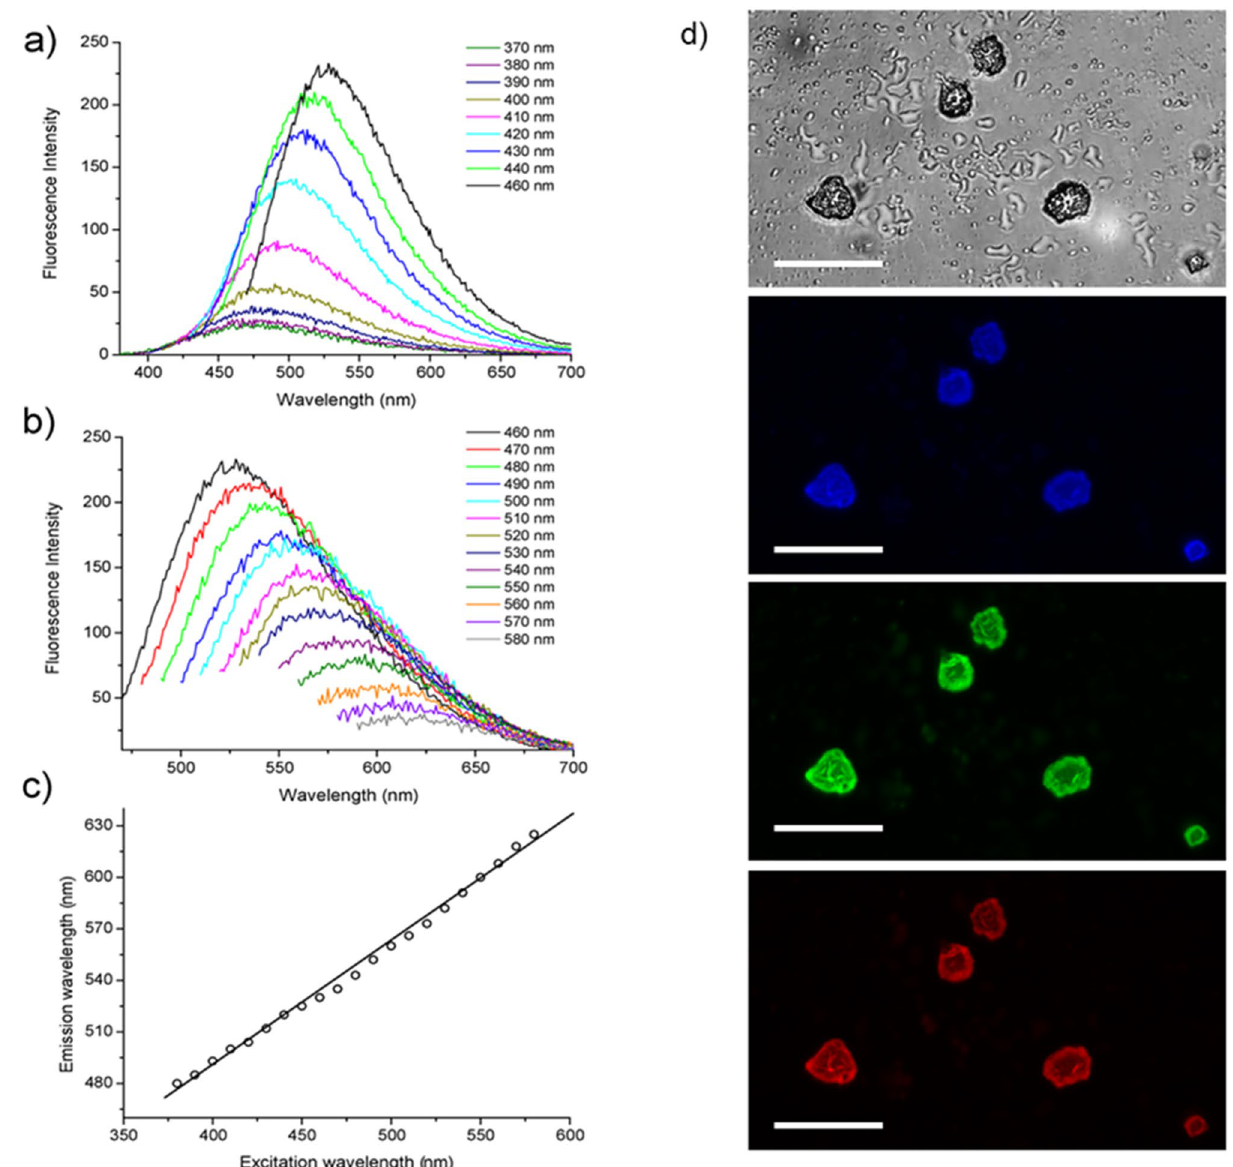
Figure 6. Fluorescence characterization. PL emission spectra of PEG6-Y4 assemblies after 4 h of heating at 5.0 mg/mL in MeOH/H 2 O (50/50) upon excitation in the range ( a ) 370 < λ exc < 460 nm and in the range ( b ) 460 < λ exc < 580 nm. ( c ) Plot of the λ em as function of the λ exc . ( d ) Fluorescence microscopy images of the heated peptide solution drop-casted on glass slides and air-dried at room temperature. Images are obtained by exciting the sample in the spectral region of: the bright field; DAPI (4 ′ ,6-diamidino-2-phenylindole; λ exc = 359 nm, λ em = 461 nm); GFP (Green Fluorescent Protein; λ exc = 488 nm, λ em = 507 nm) and Rho (Rhodamine; λ exc = 555 nm, λ em = 580 nm). The scale bar of all the images is 5 between the oligomeric species. A slight red shift for the maximum can be detected for the assemblies prepared in 100% MeOH (Fig. S7). This slight shift is probably attributable to the different polarity of the solvent used for the preparation of the samples. As expected, heated PEG6-Y4 nanospheres keep their optoelectronic properties also at the solid state (Fig. 6d). The same optoelectronic behavior was also observed for the nanospheres prepared by sonochemical approach 28–31 . The photostability of our Tyr-based nanospheres at the solid state was evaluated on the drop-casted sample by comparing the fluorescence bleaching rate of the nanospheres under continuous excitation for 180 min in the GFP spectral region (λexc = 488 nm). Selected immunofluorescence images of nanospheres, recorded at different time points, clearly indicate that the fluorescence intensity of nanoparticles gradually decreased down to half of the initial value after 45 min (Fig. S9). We also evaluated the optoelectronic properties of Tyr-based nanospheres prepared by directly heating the peptide powder in place of the peptide solution. The resulting nanoparticles exhibit the same structural and fluorescence properties (data not shown) of nanoparticles generated in presence of water. This result suggests that contrarily to the sonochemical approach,